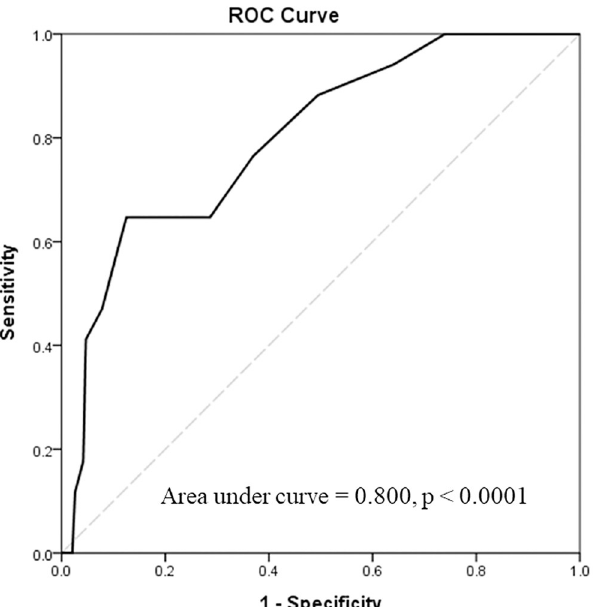
Fig 3. Receiver operating characteristic analysis of the predictive accuracy of total plaque score on the presence of carotid stenosis progression. The area under the curve of the total plaque score was 0.800 ( P < 0.001), suggesting reasonable accuracy in predicting carotid stenosis progression within the following 2